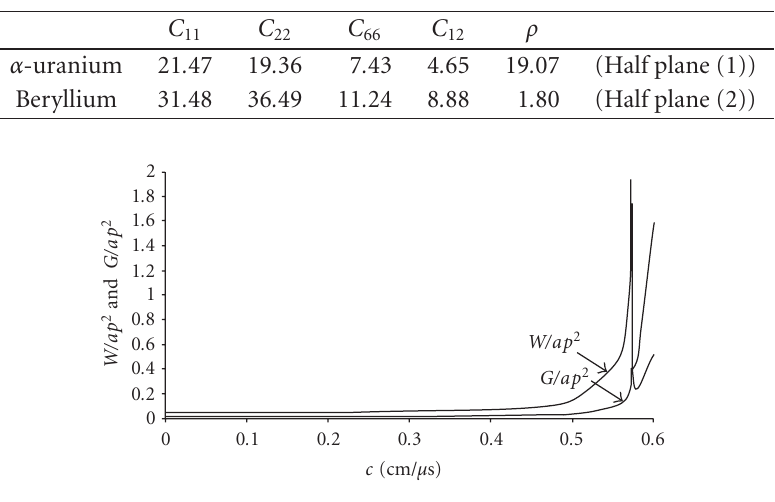
Figure 5.1. Plot of W/ap 2 and G/ap 2 versus c